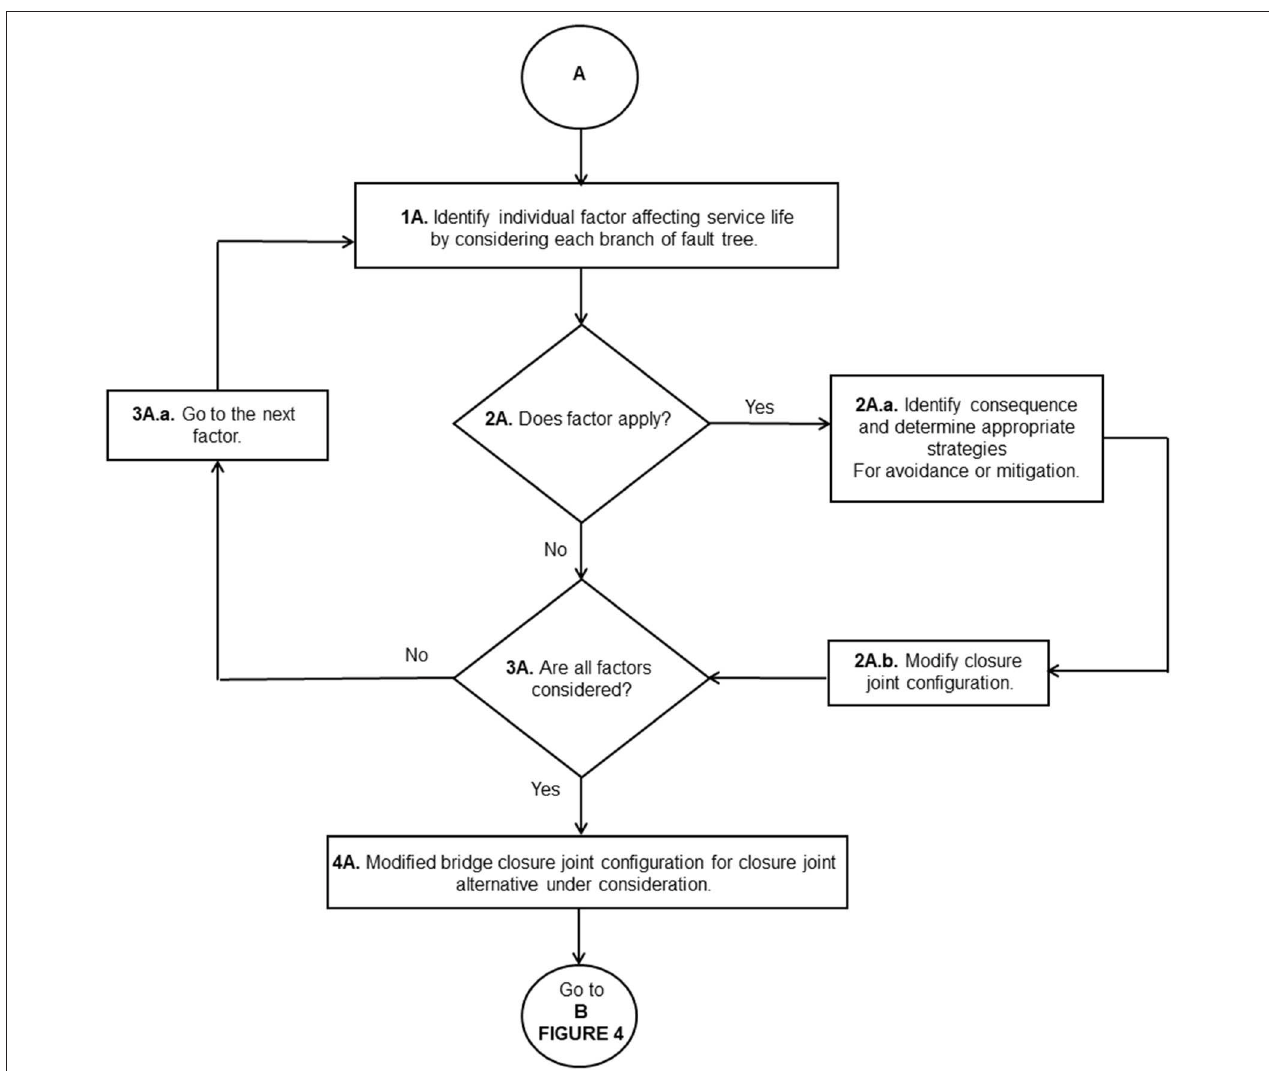
FIGURE 5 | Bridge closure joint selection process